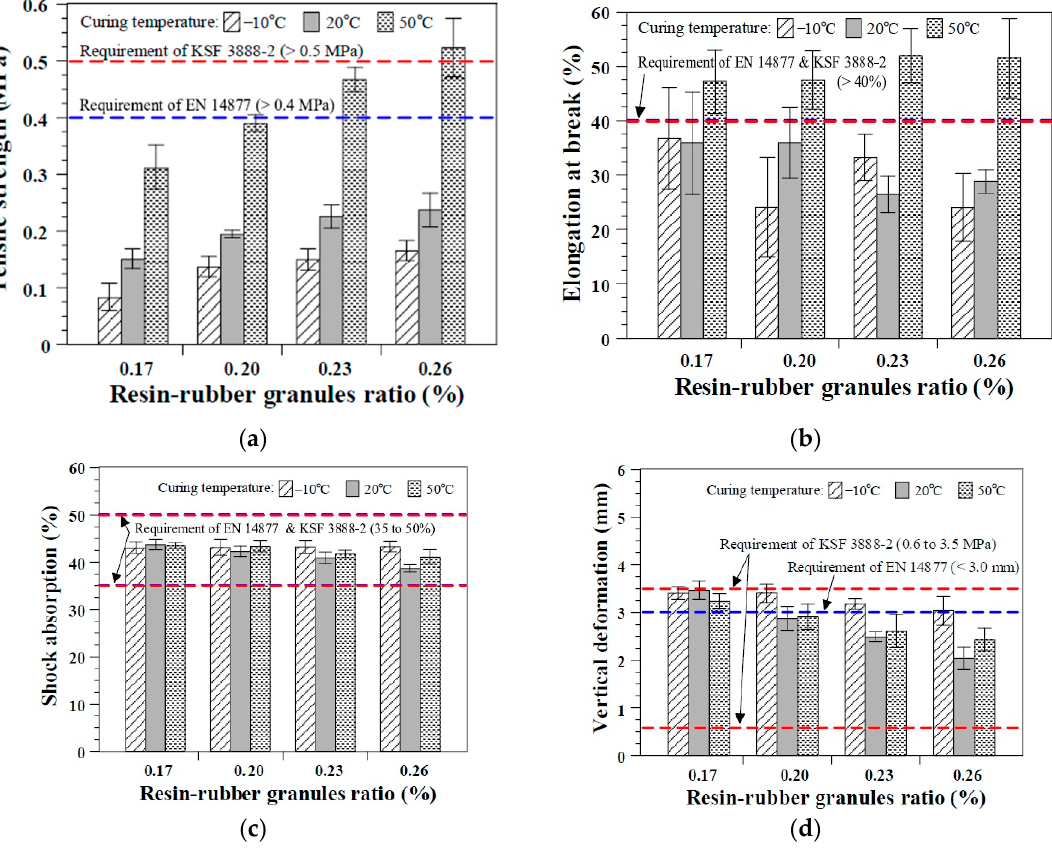
Figure 8. Effects of the curing temperature and resin–rubber granule ratio: ( a ) Tensile strength; ( b ) elongation at break; ( c ) shock absorption; and ( d ) vertical deformation.